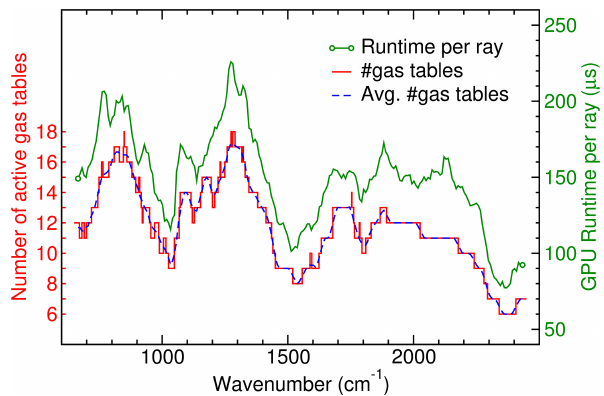
Figure 9. GPU runtime per ray as a function of wavenumber. Bun- dles of 32 wavenumbers from 650 to 2449cm − 1 in steps of 8cm − 1 have been benchmarked with up to 27 gases in the limb case. The averaged number of active look-up tables acts as a rolling average over 32 adjacent wavenumbers.